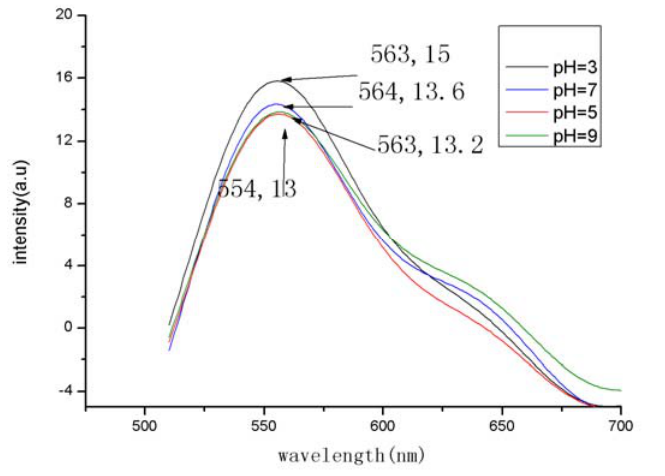
Figure 1. Fluorescence spectra of folate-TO at different pH (excition at 480 nm was used with slit width of 10 nm and emission slit width of 10 nm).